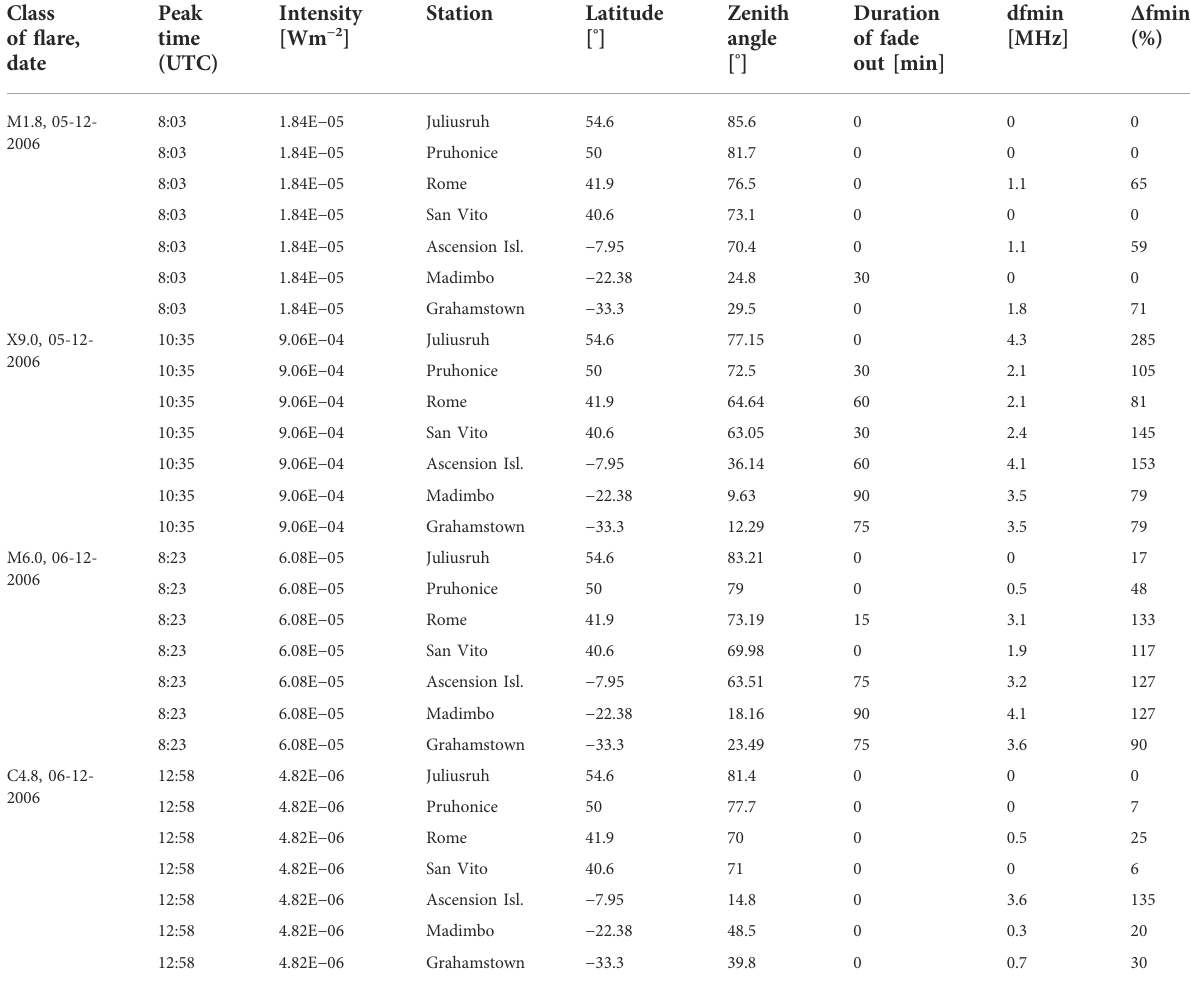
TABLE 2 Class, date, peak time of the investigated fl ares,furthermore the latitude and solar zenith angle at the peak time of the fl ares of the different ionosonde station, and the detected duration of fade-out (at the time of the fl are), dfmin and Δ fmin variation (at the time of the fl are and/or measured after the